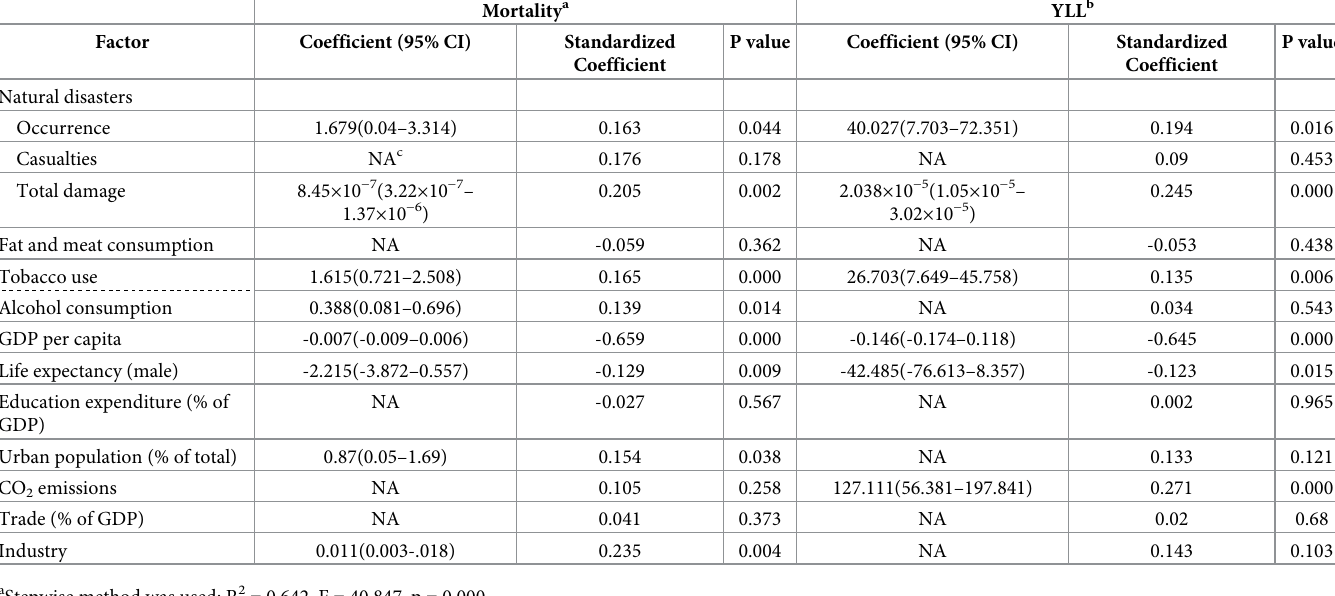
Table 3. Multivariate linear regression-derived coefficients for the associations of natural disasters and socioeconomic variables with IHD mortality and YLL rates among males from 1990 to 2017 in 193 countries, weighted by population.